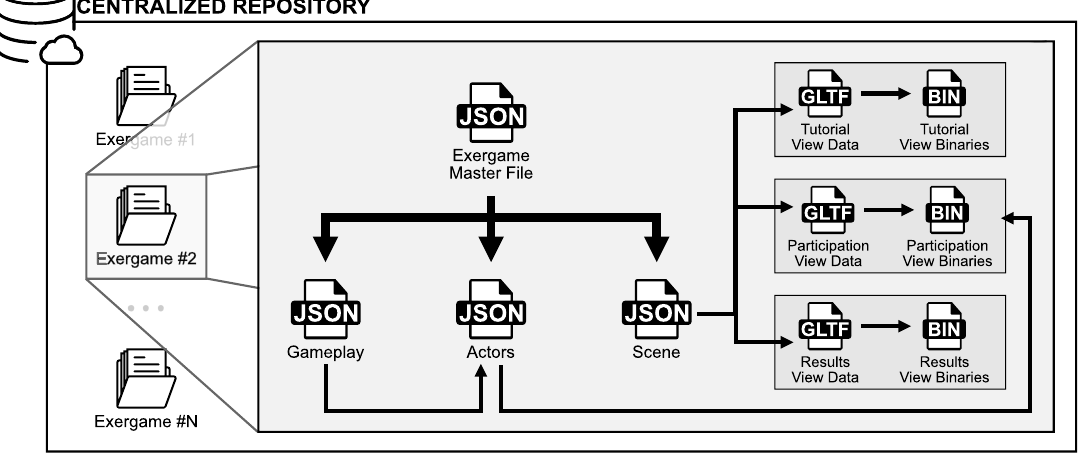
Figure 3. Diagram of files that represent an exergame and references that are maintained with one another (within context of remote exergame